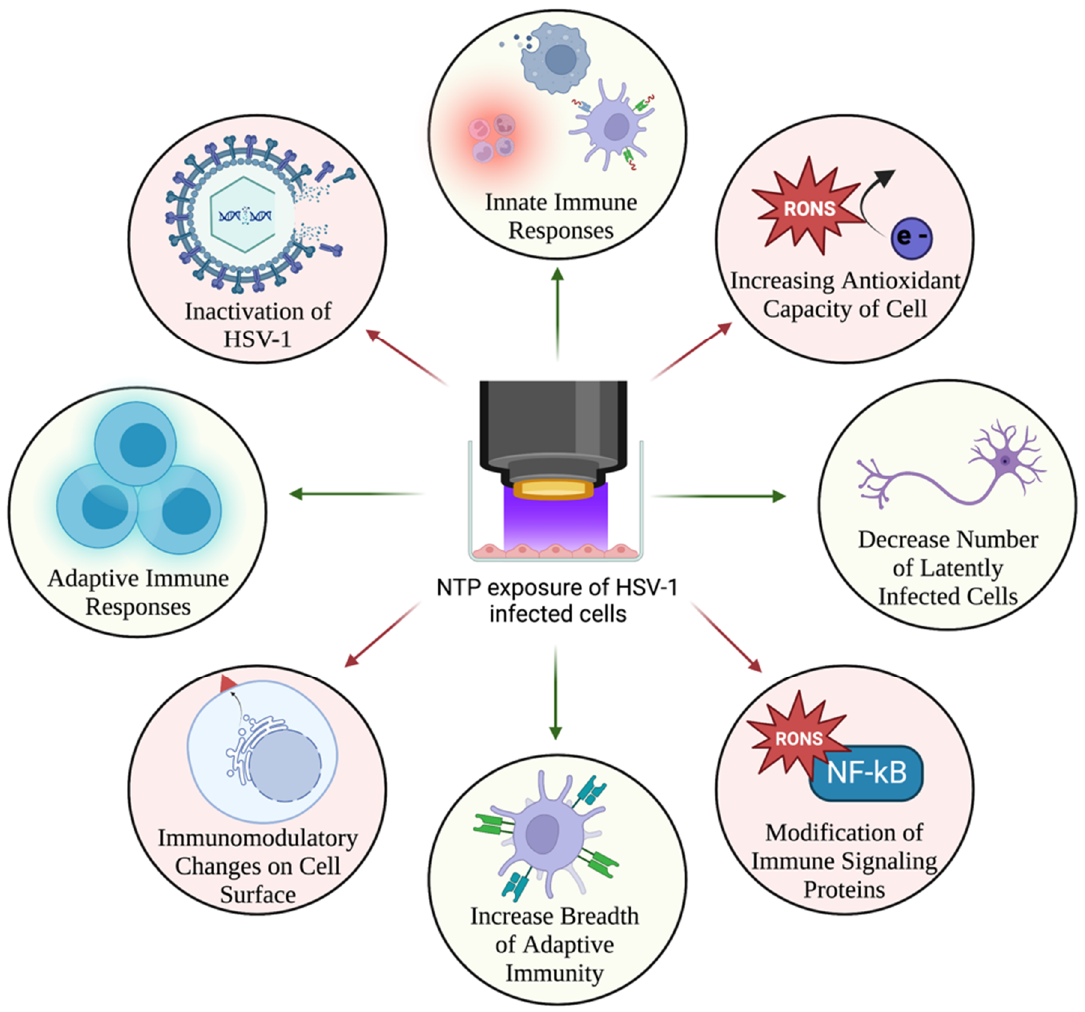
Figure 7. NTP is a potential antiviral and immunomodulatory agent for HSV-1 infection. We propose that the exposure of HSV-1-infected cells to NTP will directly (red) result in the inactivation of HSV-1 virion components and promote the display of SAMPs on the cell surface. Additionally, NTP-generated RONS can directly modify signaling proteins to activate immune signaling and balance redox levels through antioxidant transcription. Based on these effects, we believe NTP will indirectly (green) promote and expand the breadth of stimulation of both innate and adaptive immune responses against HSV-1. In return, this will decrease the amount of virus that can travel into the nervous system to establish viral latency in peripheral ganglionic neurons, ultimately reducing the frequency of reactivation over time.